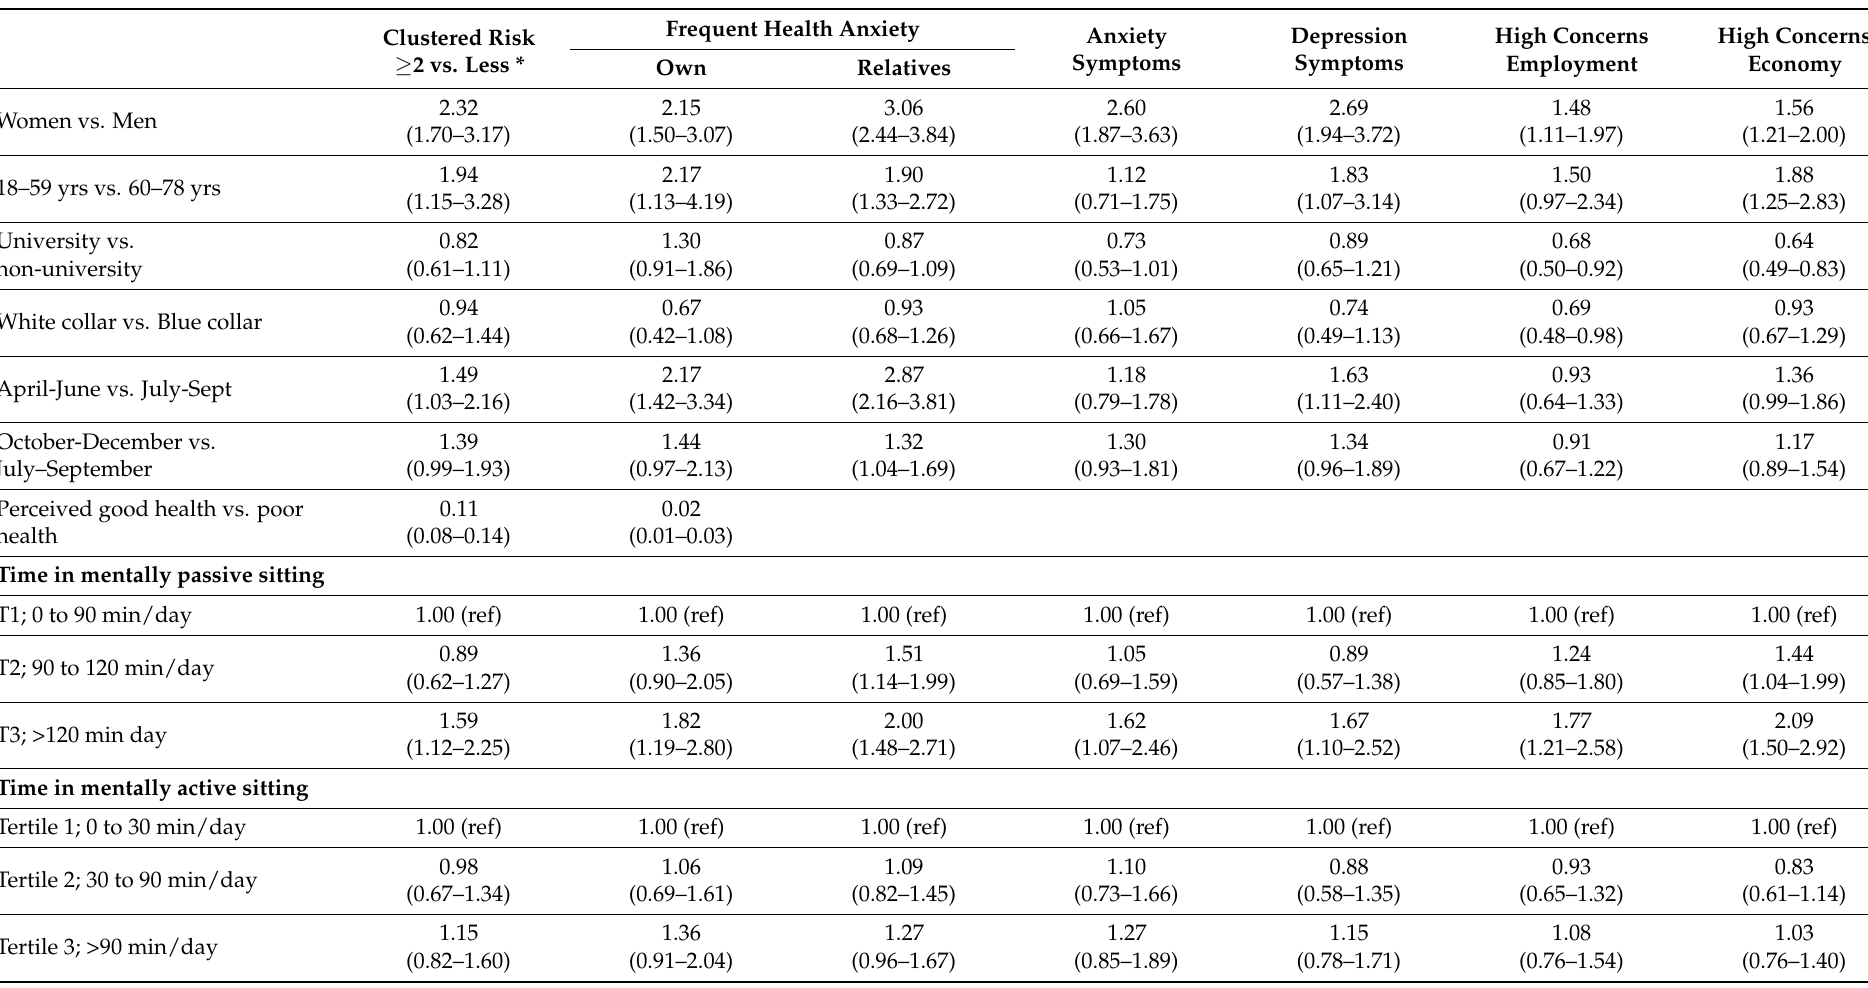
Table 5. Odds ratio (95% CI) for clustering of mental-ill health, as well as each individual mental ill-health variable, in relation to sex, age, occupational group, educational level, and wave of COVID-19 pandemic (above) and time sitting and engaging in either mentally passive, mentally active, or socializing activities (below). Frequent Health Anxiety Anxiety Clustered Risk ≥ 2 vs. Less * EconomyOwn Relatives Women vs.